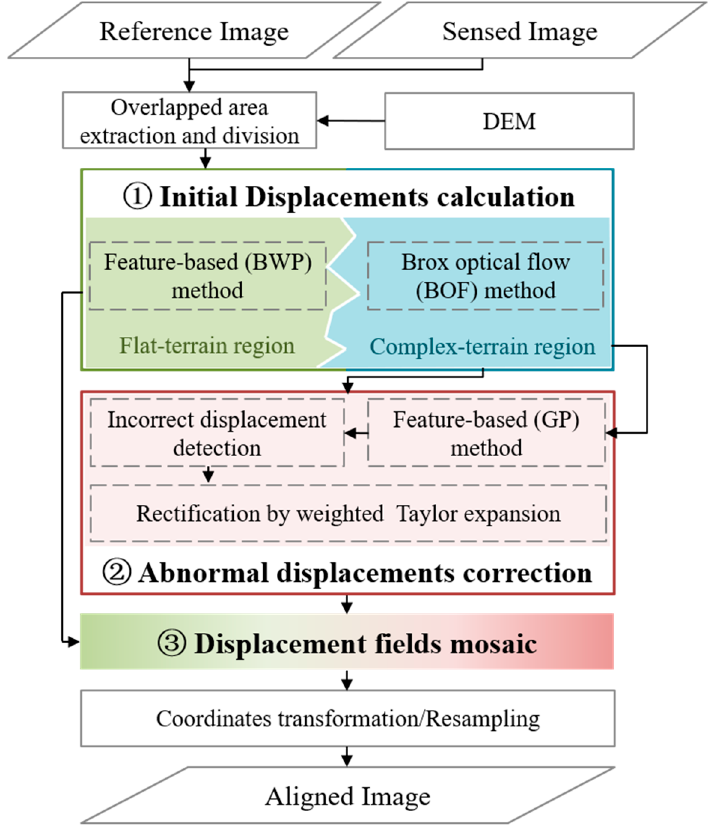
Figure 1. The flow-chart of the processed algorithm.